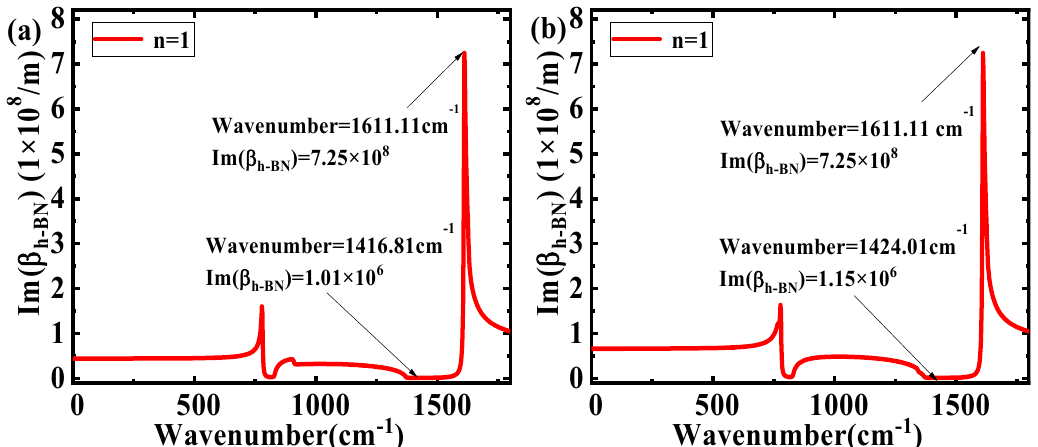
Figure 4. Im( β h-BN ) as a function of wavenumber in di ff erent ε 1 and ε 2 : ( a ) ε 1 = 1 (air), ε 2 = 3.9 (SiO 2 ), Figure 4. Im( β h ‐ BN ) as a function of wavenumber in different ε 1 and ε 2 : ( a ) ε 1 = 1 (air), ε 2 = 3.9 (SiO 2 ), d d = 50 nm; and ( b ) ε 1 = 1 (air), ε 2 = 11.9 (Si), d = 50 nm. Nanomaterials 2019 , 9 , x FOR PEER REVIEW = 50 nm; and ( b ) ε 1 = 1 (air), ε 2 = 11.9 (Si), d= 50 nm.